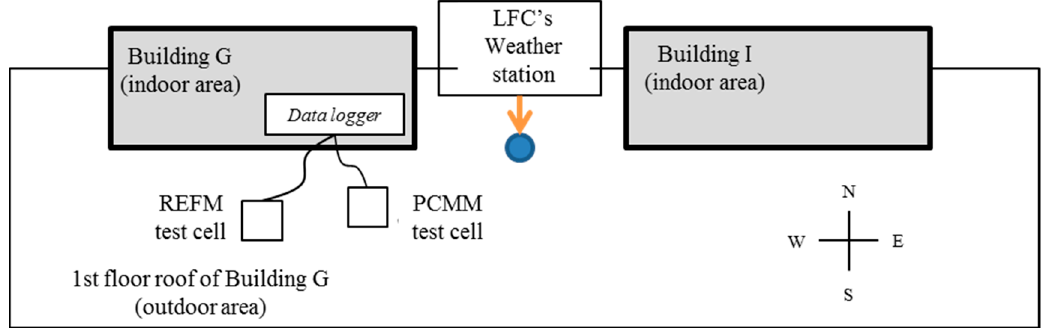
Figure 2. Plan of FEUP’s main buildings G and I: Pilot test cells outdoor arrangement set.